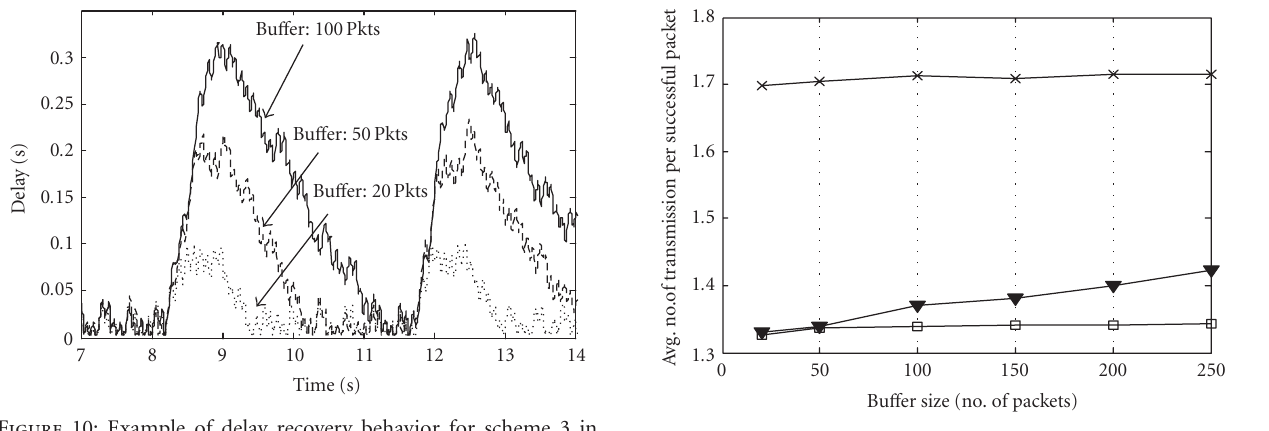
Figure 10: Example of delay recovery behavior for scheme 3 in Table 2.